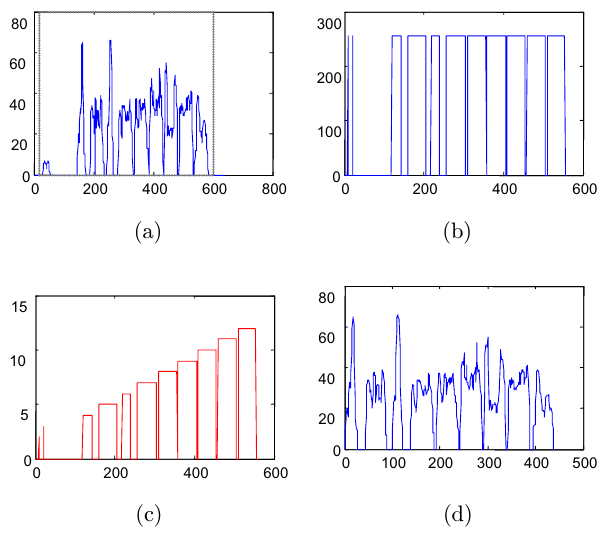
Fig. 7. Vertical projection mapping of Fig. 4(f) and ¯ltering. (a) vertical projection curve, (b) binary projection curve, (c) region labeling and (d) after noises ¯ltering